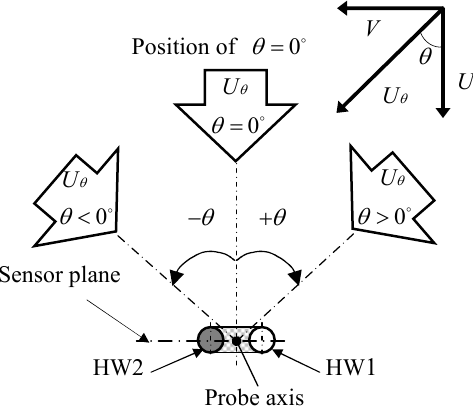
Fig. 2 Definition of the sensor plane and its position facing the flow